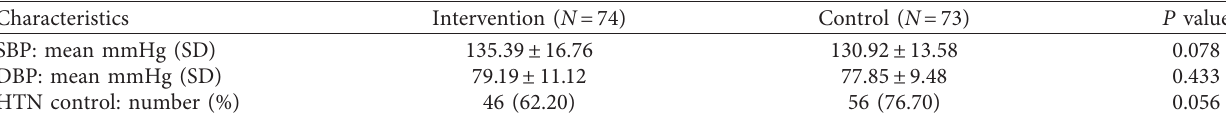
Table 2: The blood pressure and HTN control rate of intervention and control groups after 12 weeks of follow-up.